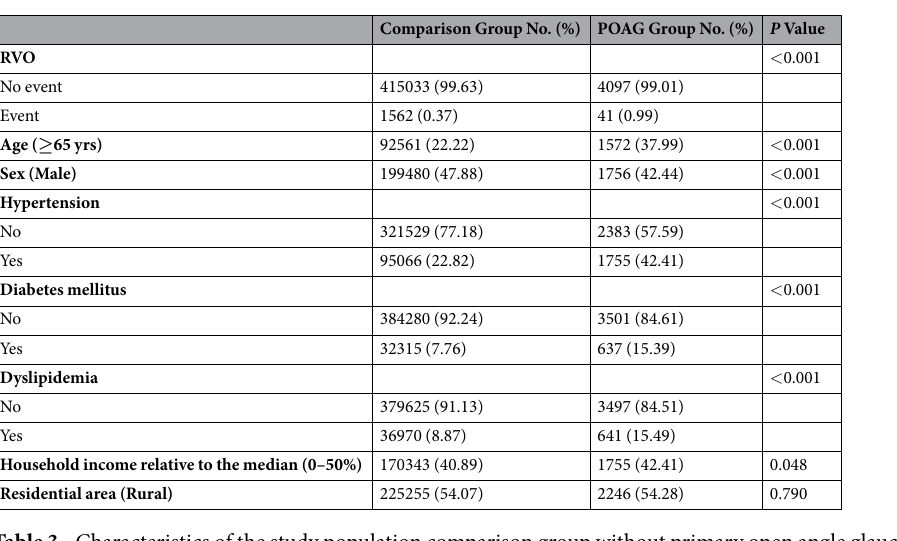
Table 3. Characteristics of the study population comparison group without primary open angle glaucoma (n = 416595) and primary open angle glaucoma group (n = 4138). POAG = primary open angle glaucoma; RVO = retinal vein